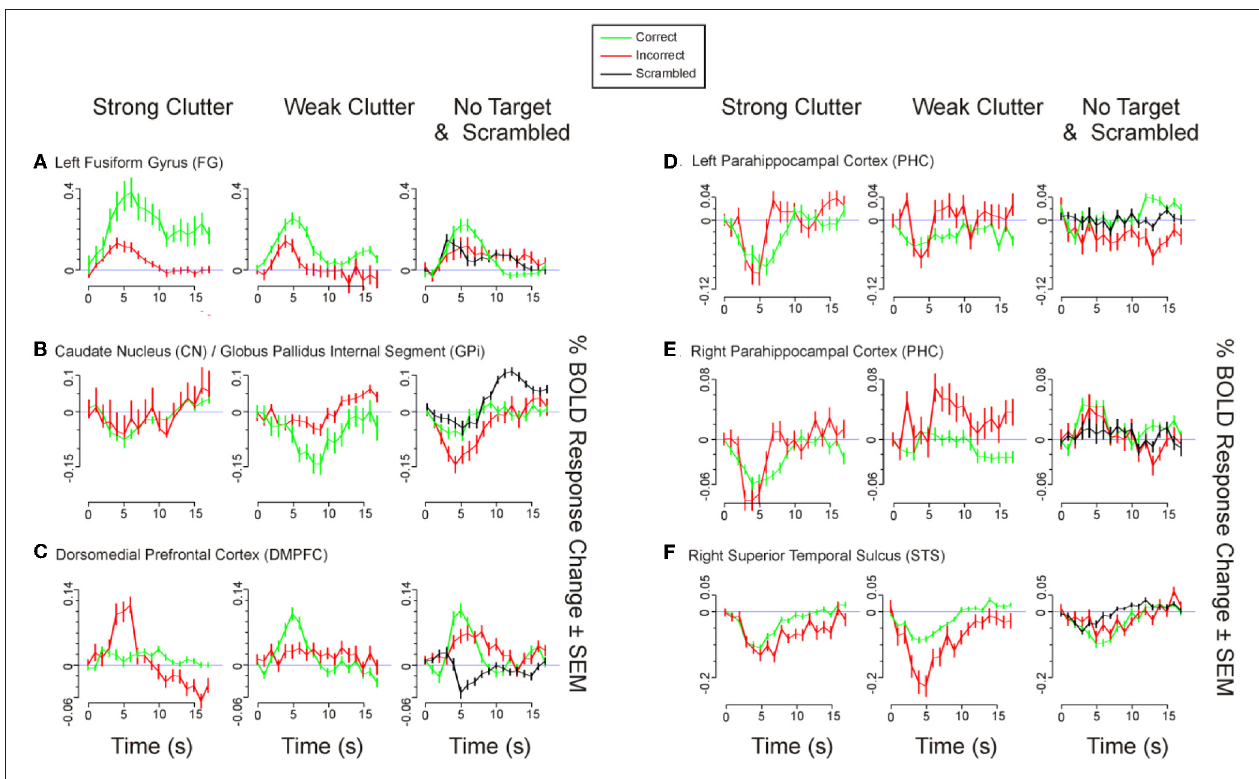
showed significant correlation with the behavioral responses. Time courses were calculated and plotted as described in the legend to Figure A1